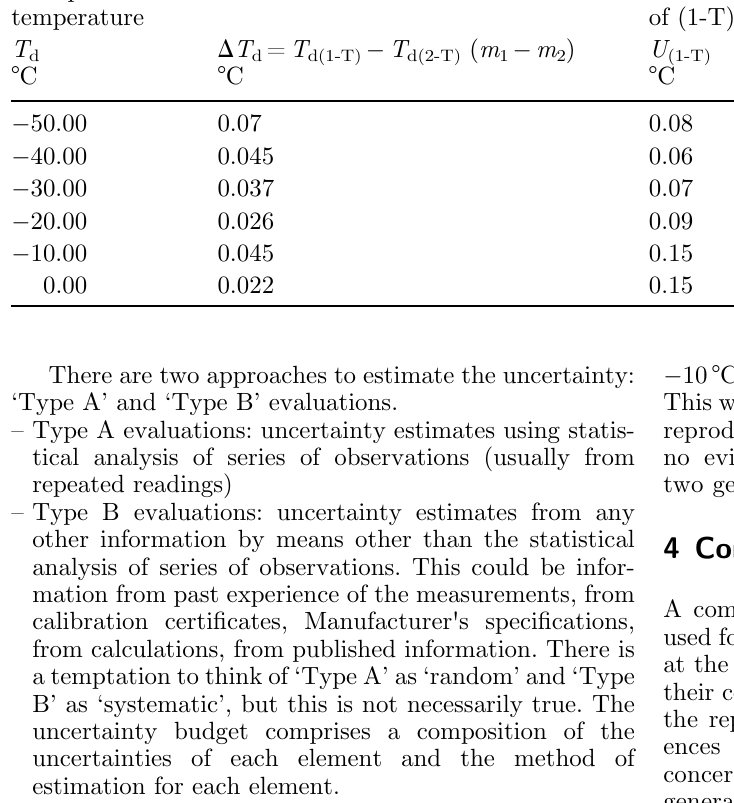
Table 2. The pair uncertainty of NIS two generators.